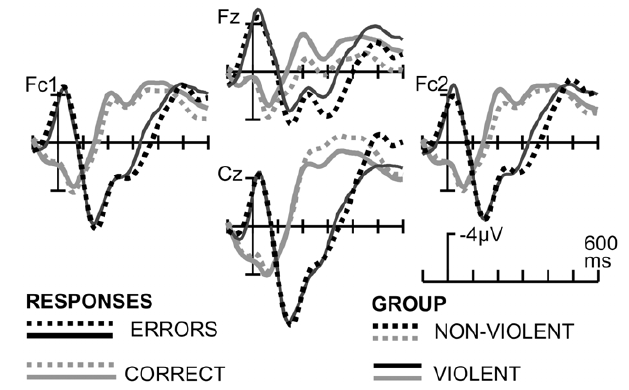
Figure 4. ERPs locked to the onset of the Feedback screen. ERPs are separated by blocks (‘‘passive’’ and ‘‘active’’; solid vs. dotted lines) and outcome (lost and won, black vs. gray line). Gray-shaded areas indicate time window of the FRN.